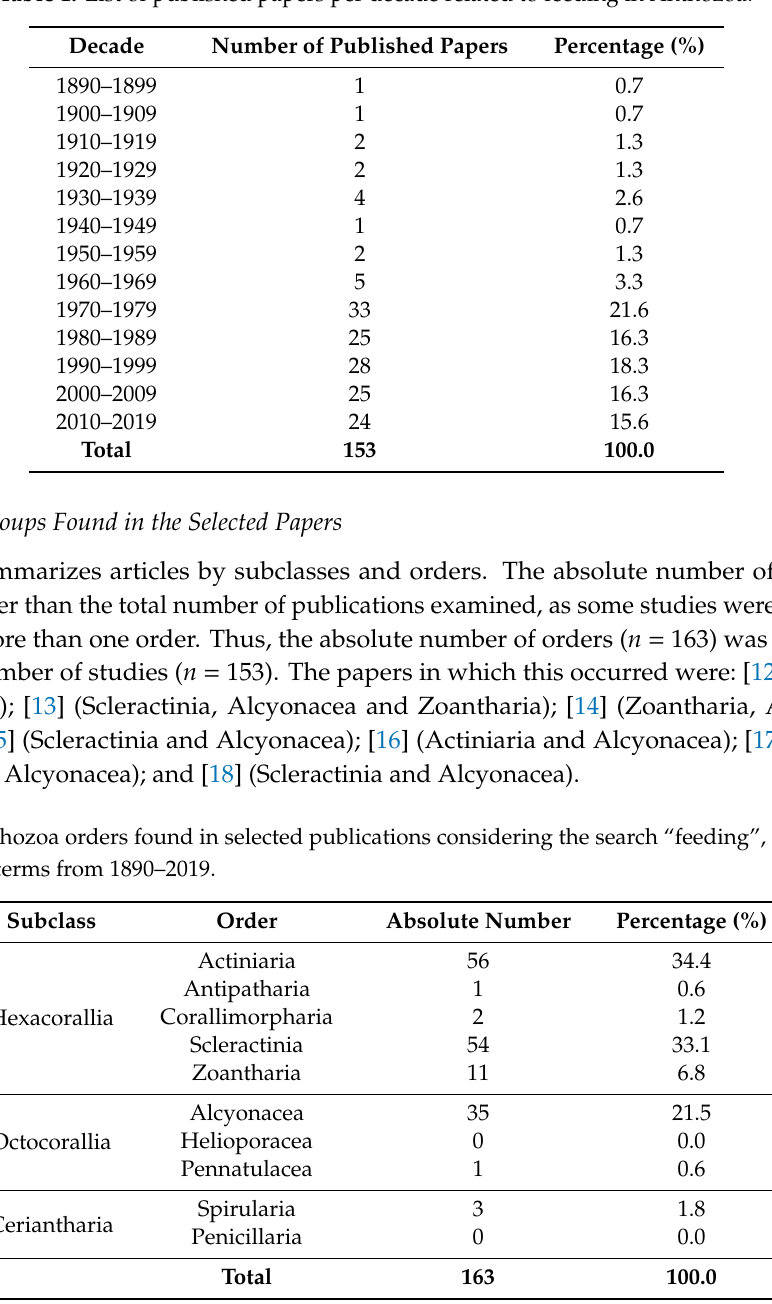
Table 1. List of published papers per decade related to feeding in Anthozoa.